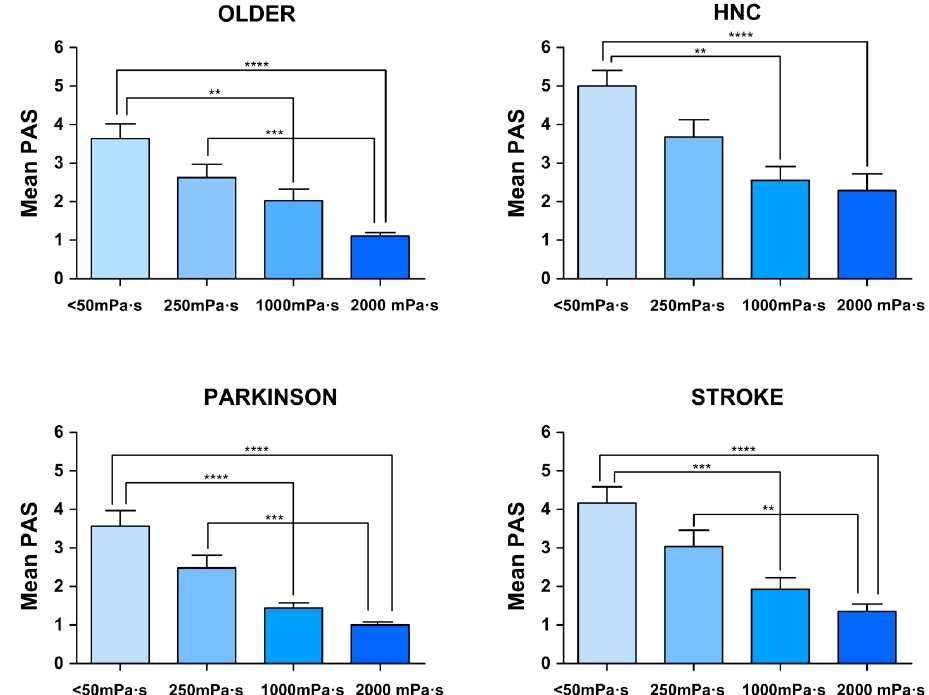
Figure 6. Mean penetration-aspiration scale (PAS) score in each viscosity of each of the study groups. * p-value <0.05, ** <0.01, *** <0.001, **** <0.001. HNC indicates head and neck cancer.